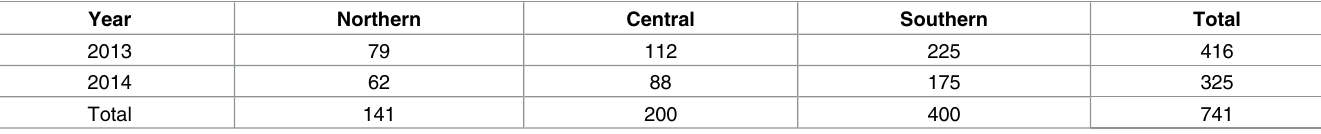
Table 2. Number of experimental fishing sets by year and